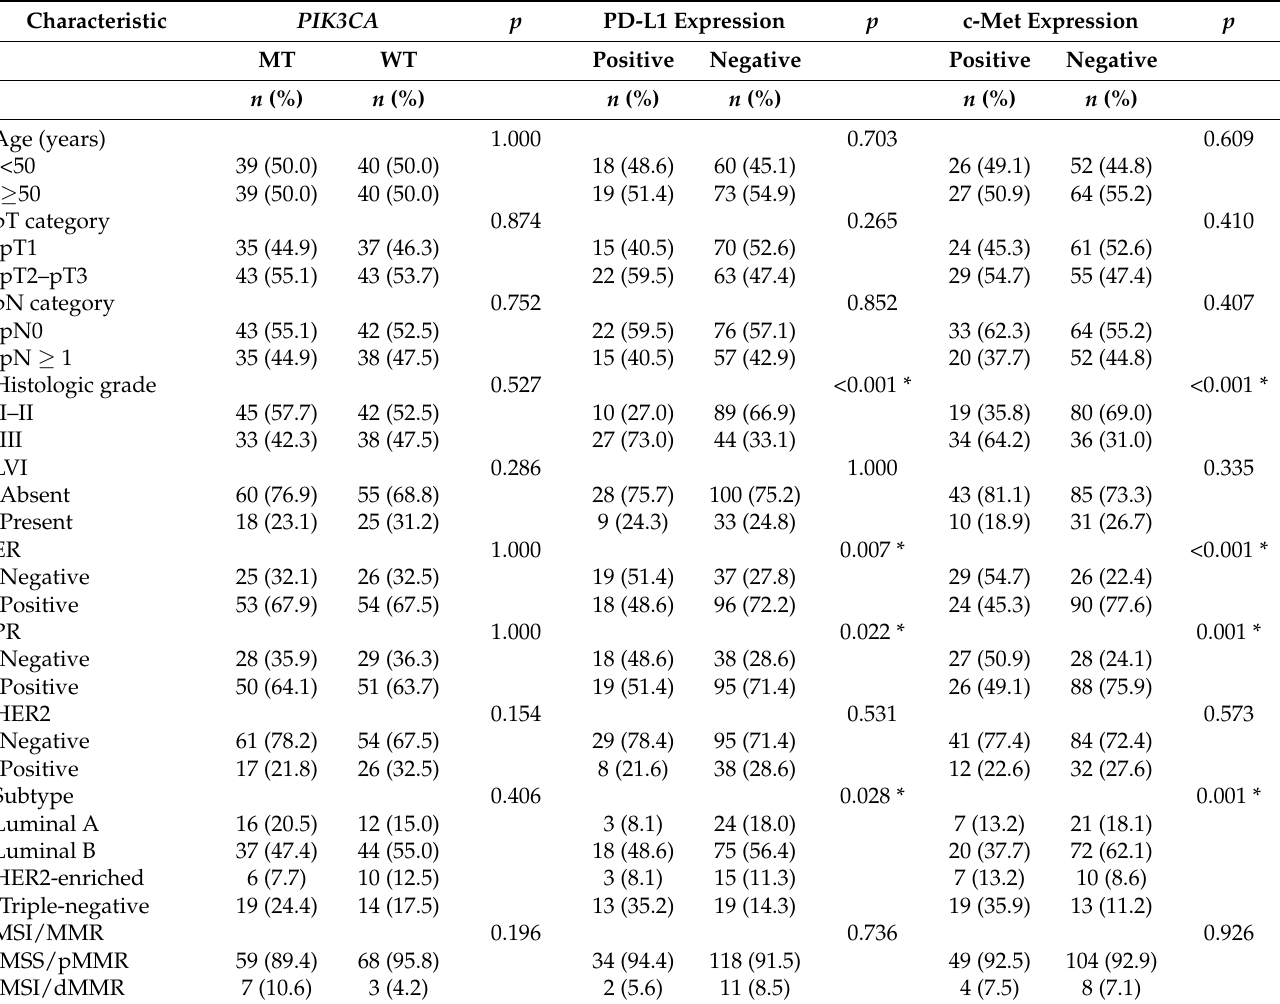
Table 1. Clinicopathologic correlations of PIK3CA mutation, PD-L1 and c-Met expression, and MSI/dMMR